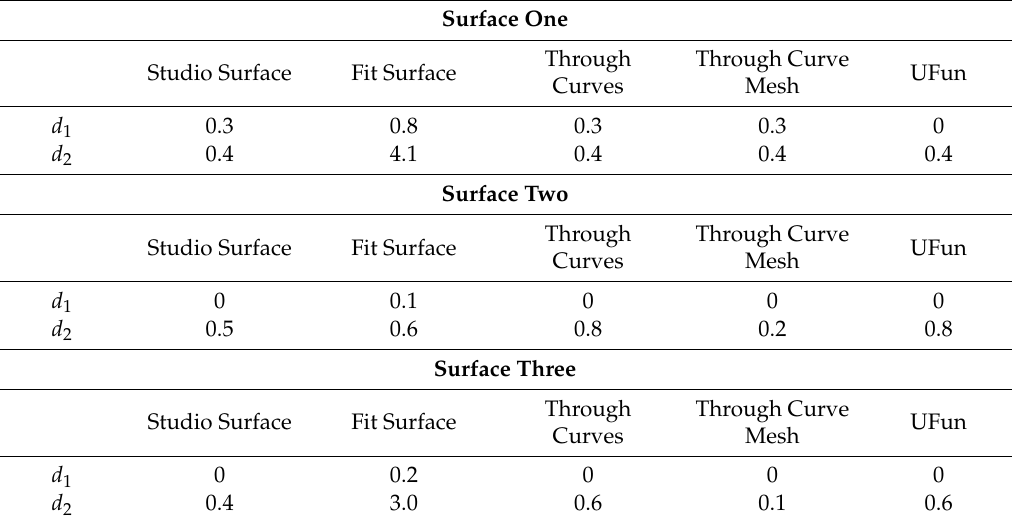
Table 1. Comparison of the five surface fitting functions in NX. Unit: µ m.